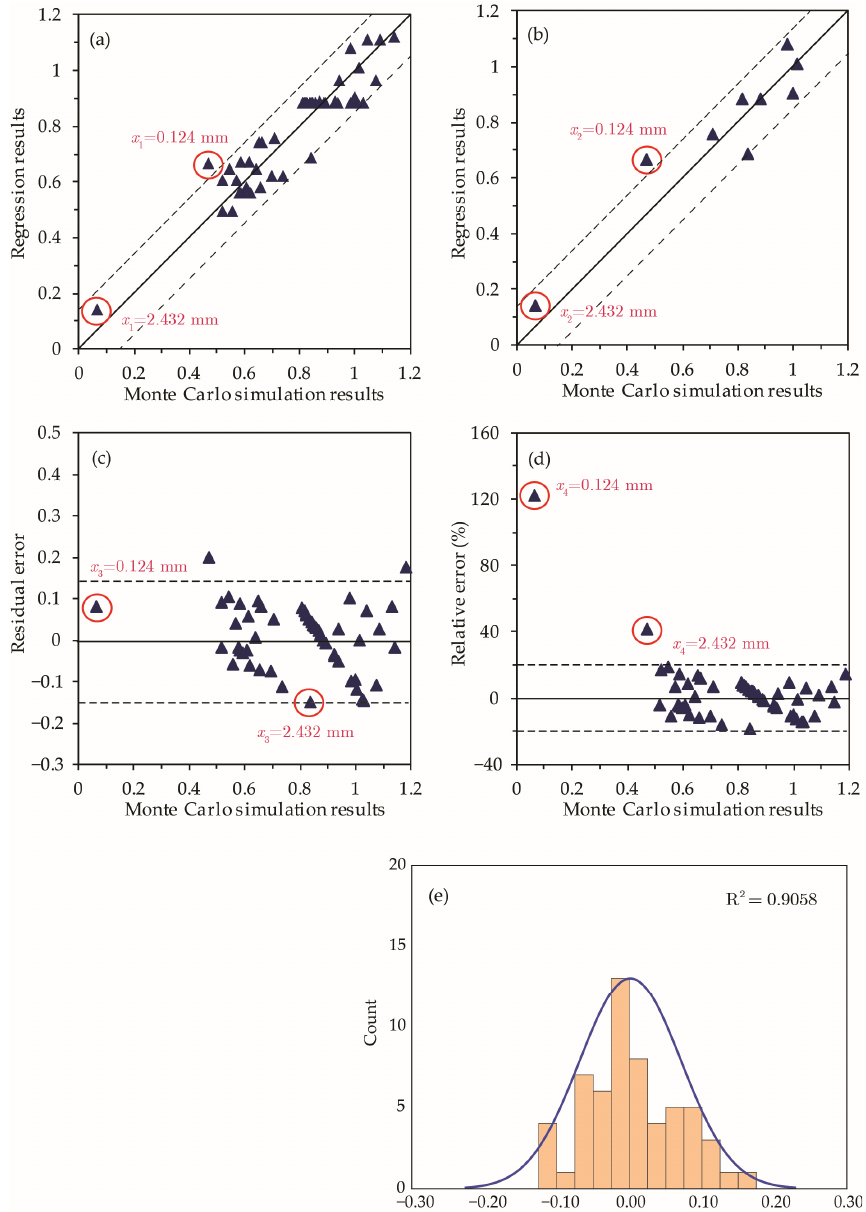
Figure 9. Comparison of different regression models for: ( a ) regression and Monte-Carlo simulation results; ( b ) regression and Monte-Carlo simulation results for level ±2.378 simulations; ( c ) residual error; ( d ) relative error; and ( e ) residual error distribution.